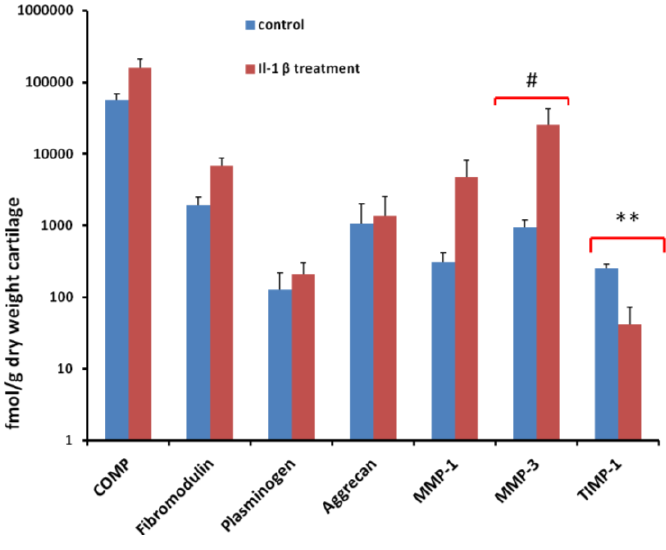
Figure 2. Proteins measured in human secretome media using QconCAT. Extracted ion chromatograms were performed for each peptide and the total ion count used to determine the ratio of light peak area/ heavy peak area at a given QconCAT loading. The protein abundance in the media was then calculated based on the amount of total protein in the media sample. This was then normalised to the dry weight of explants. Mean concentrations and ±SEM ( n = 3) are indicated. Data were evaluated using mixed effect linear